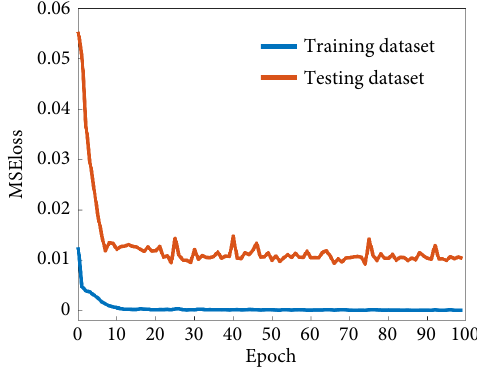
Fig. 5 Loss variation of homemade ConvNet model with epoch for training and testing